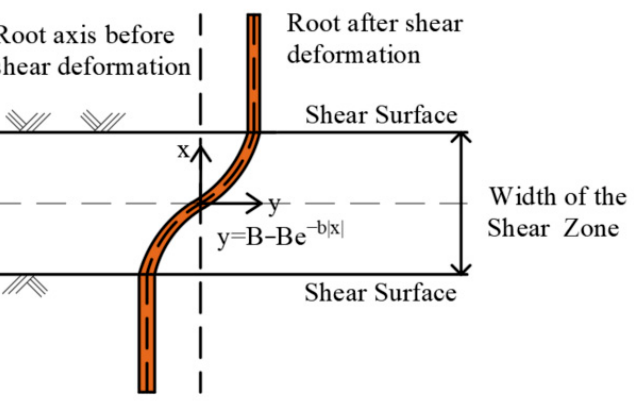
Figure 3. Schematic diagram of the displacement-based model (Modi fi ed from (Fan, 2012) [32]).